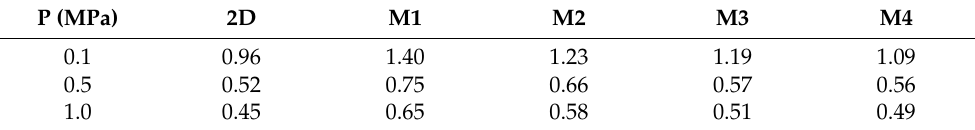
Table 2. The value of R obtained by different models at pressure of 0.1, 0.5 and 1.0 MPa. P